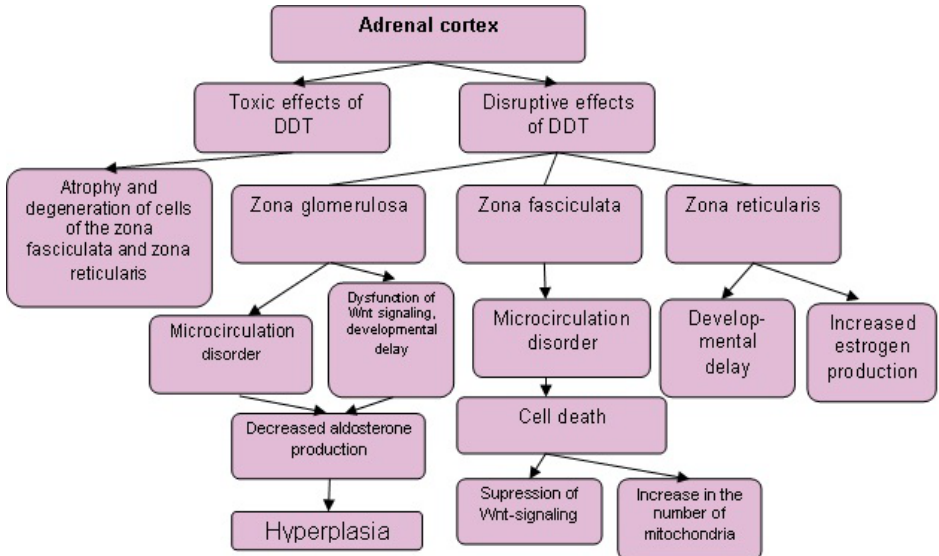
Figure 2. Changes in the morphogenesis and secretory activity of the adrenal cortex after exposure to toxic and disruptive doses of